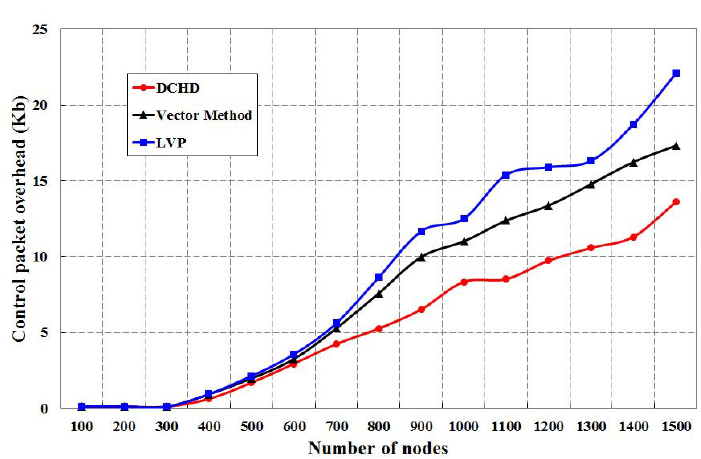
Figure 14. Control packet overhead of DCHD as compared to other